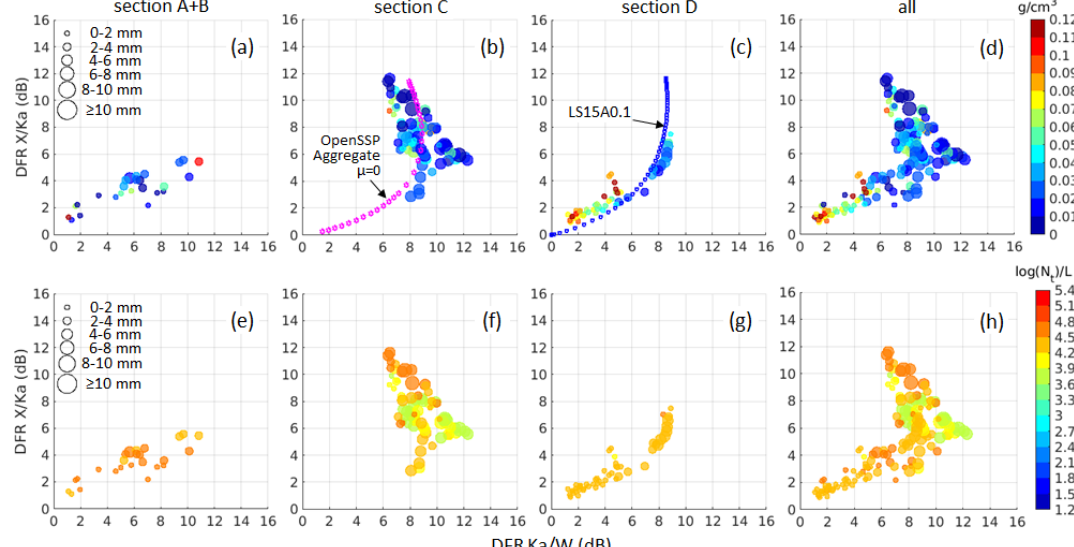
Figure 15. Similar to Fig. 14 but for flight segment 20:05–20:28UTC. The magenta line (in panel b ) is for the aggregation scattering model (Kuo et al., 2016), and the blue line (in panel c ) is for riming model A with an effective liquid water path of 0.1kgm − 2 (Leinonen and Szyrmer, 2015).